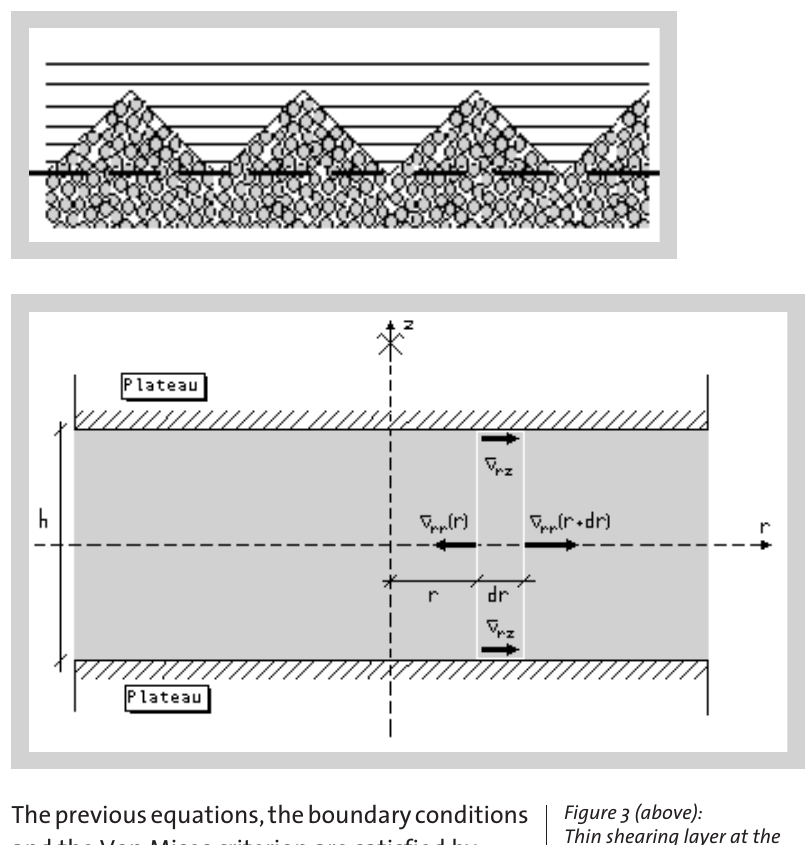
Figure 3 (above): Thin shearing layer at the interface in the case of rough plates. Figure 4 (below): Global equilibrium of a volume